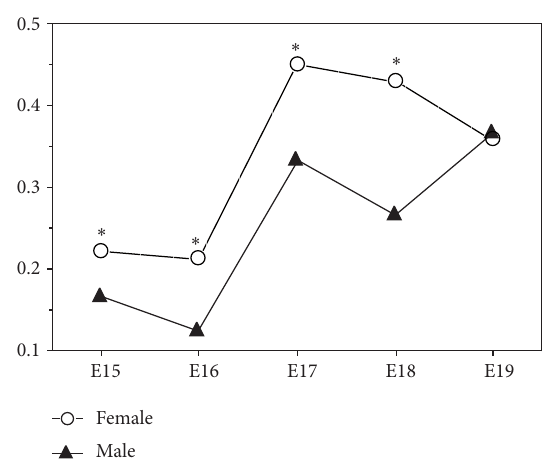
F 2: Lung retinyl palmitate in the male and female foetuses of control group (ng/ (all SD values were signi�cant).